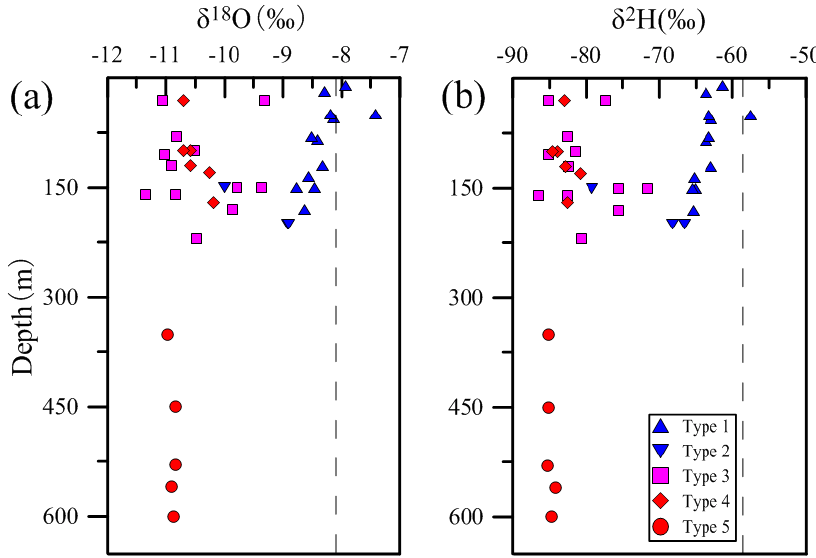
Figure 7. The plot of ( a ) the δ 18 O value and ( b ) the δ D value in groundwater versus the depth of sampling: The dashed lines in Figure 7a,b denote the mean δ 18 O ( − 8.1‰) and δ 2 H ( − 58.5‰) values of modern rainfall in the Ordos Plateau, respectively.